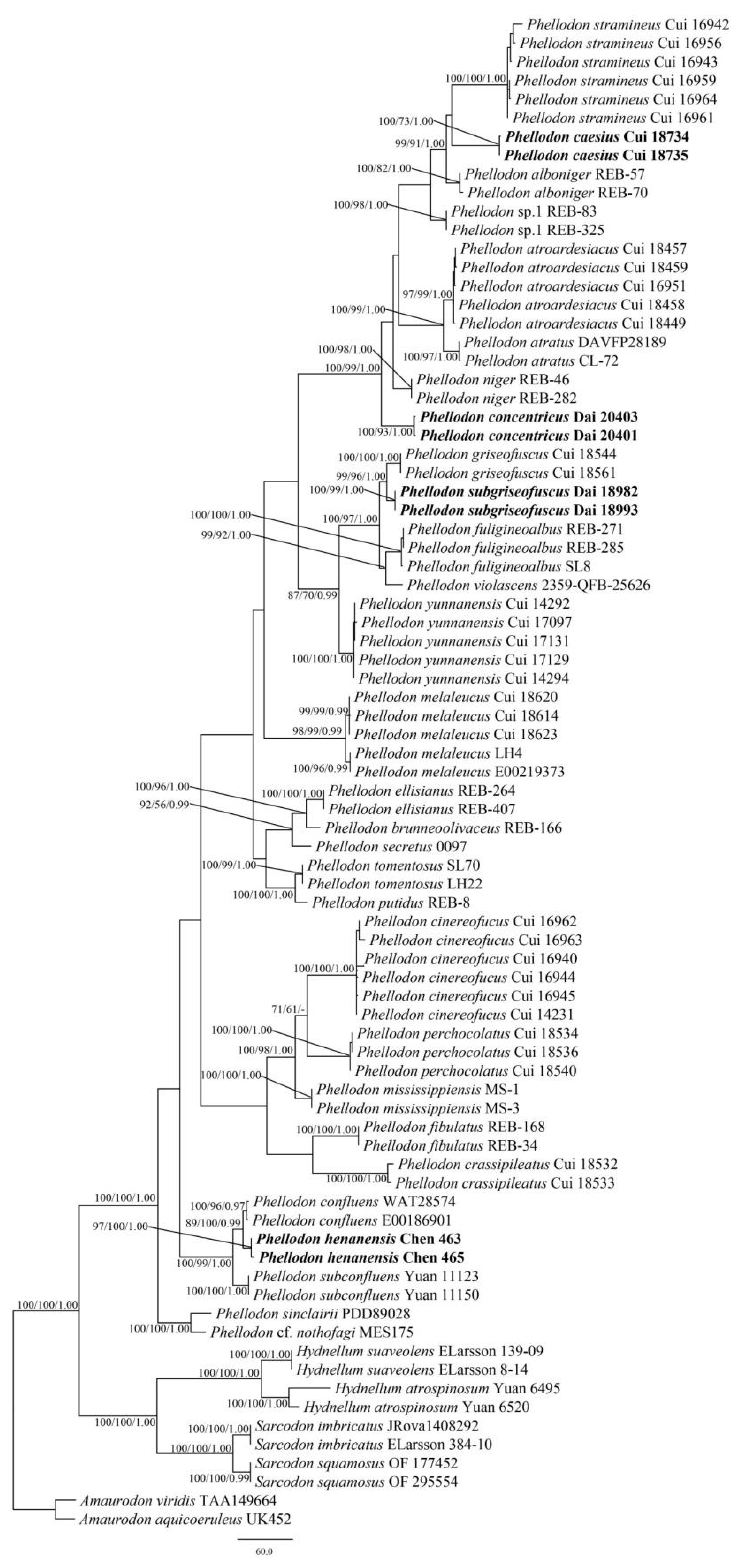
Figure 2. Maximum parsimony (MP) phylogram of the Phellodon species based on ITS + nLSU + nSSU + RPB1 + RPB2 sequences data. The supported branches are labeled with parsimony bootstrap values higher than 50%, maximum likelihood bootstrap values higher than 50%, and Bayesian posterior probabilities more than 0.95. Bold names = New species.